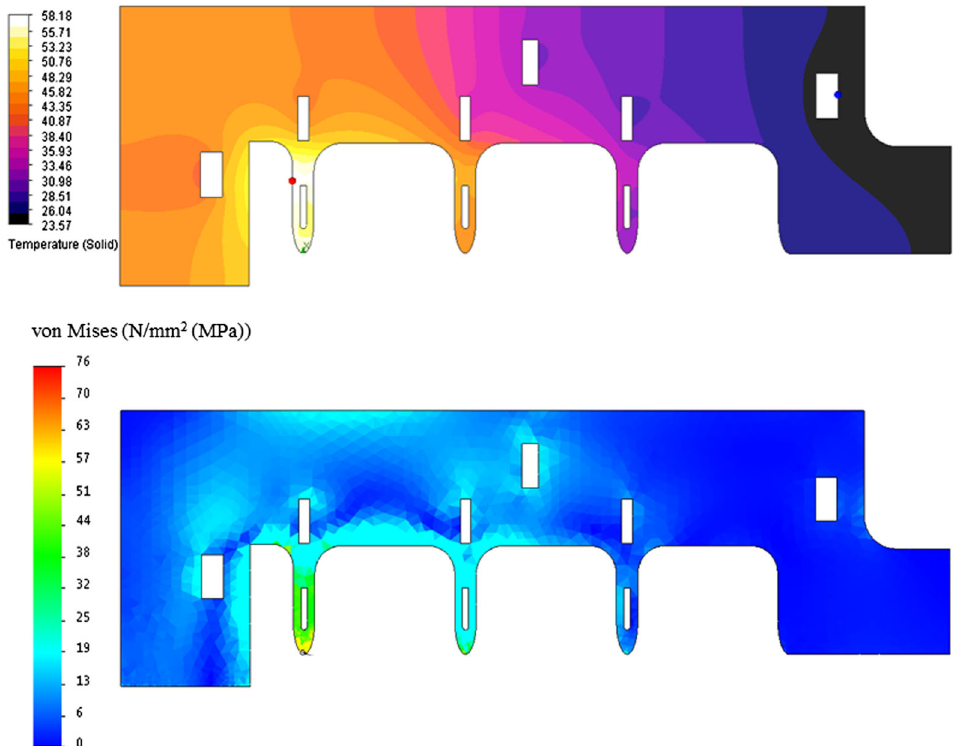
FIG. 20. Finite element models of the rf photoinjector used for thermal and mechanical analysis. The upper plot shows temperature at a 3 kW average field corresponding to 3 MW peak and 1 μ s pulses at 1 kHz repetition rate for a 0.1% duty cycle. The maximum temperature rise is 35 °C. The lower plot shows the induced thermal stresses. There is one small area of maximum stress greater than 50 MPa at the tip of the first iris. Further optimization, in the form of iris modifications, will reduce this peak stress below that